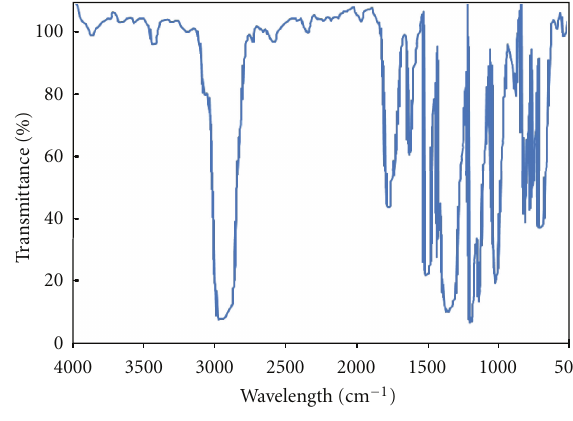
Figure 7: FTIR spectrum of reference sample.